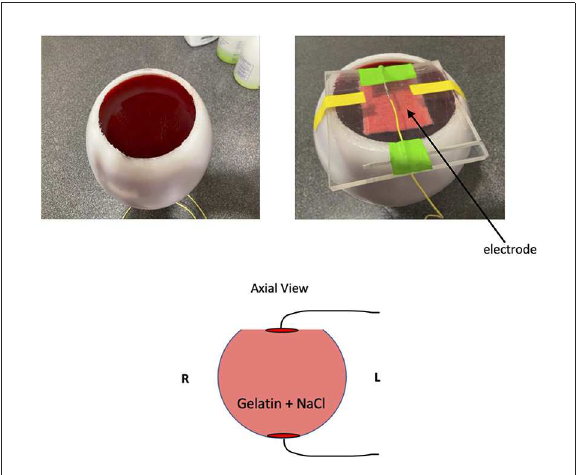
FIGURE2 Phantom experiment setup. We crafted a gelatin phantom doped with NaCl to reduce T1 as well as add electrical conductivity. In the cartoon diagram, the two red disks on the top and bottom of the phantom indicate the location of